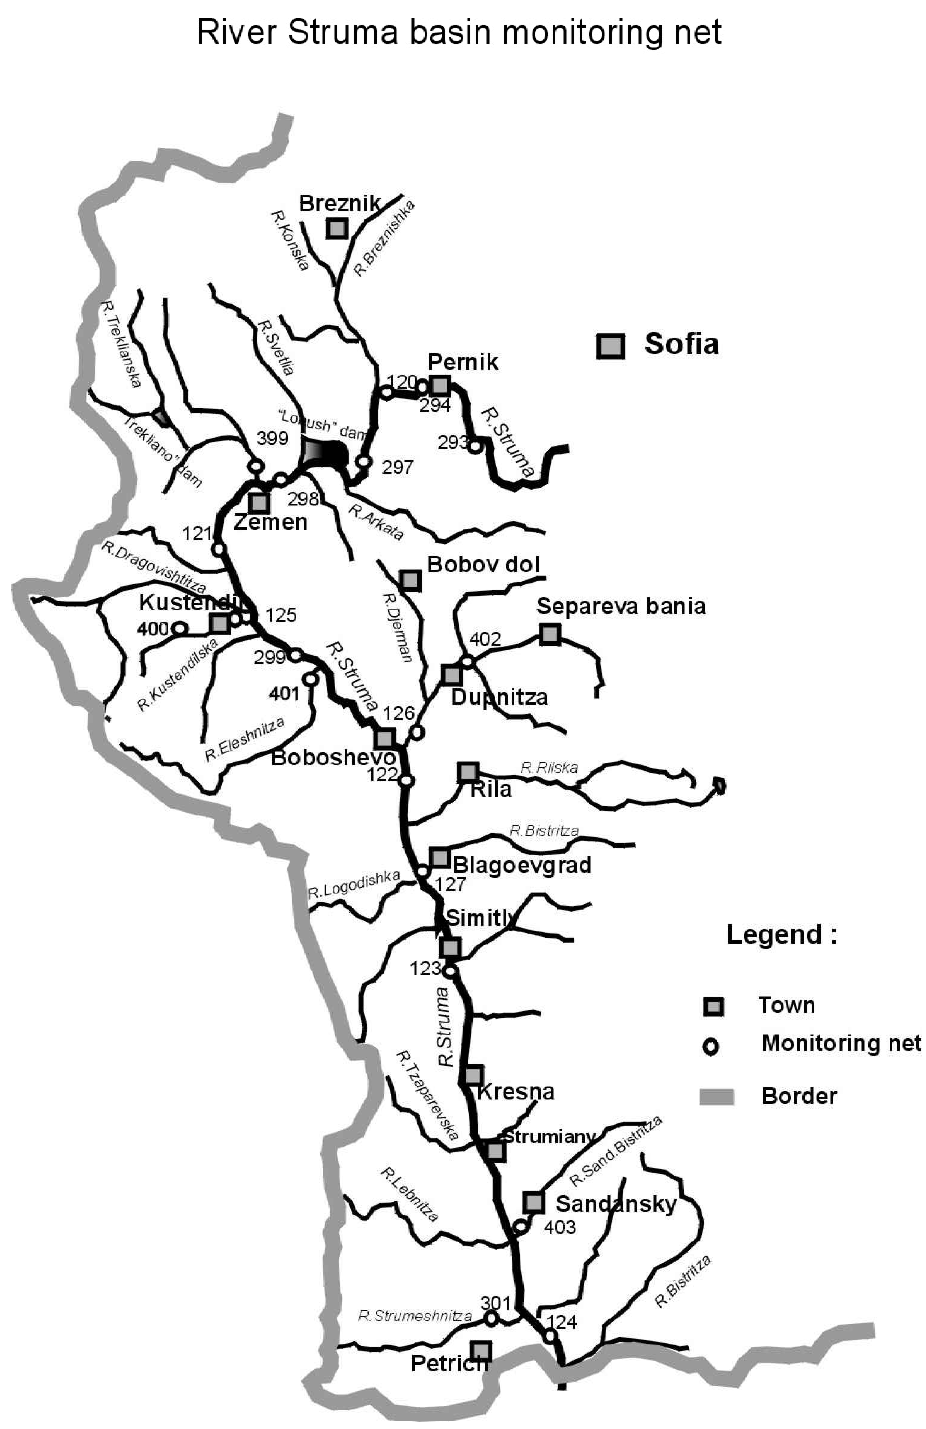
Fig. 1 Struma River monitoring